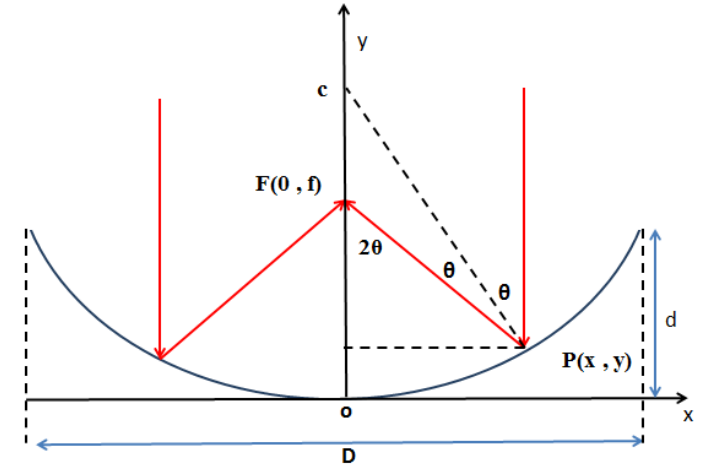
Figure 14. Schematic view of a parabolic mirror